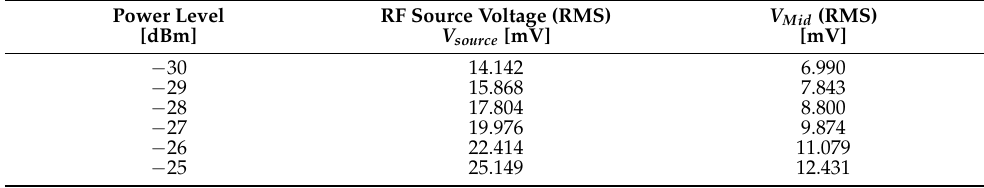
Table A2. Output power and corresponding voltages for the open-circuited measurement